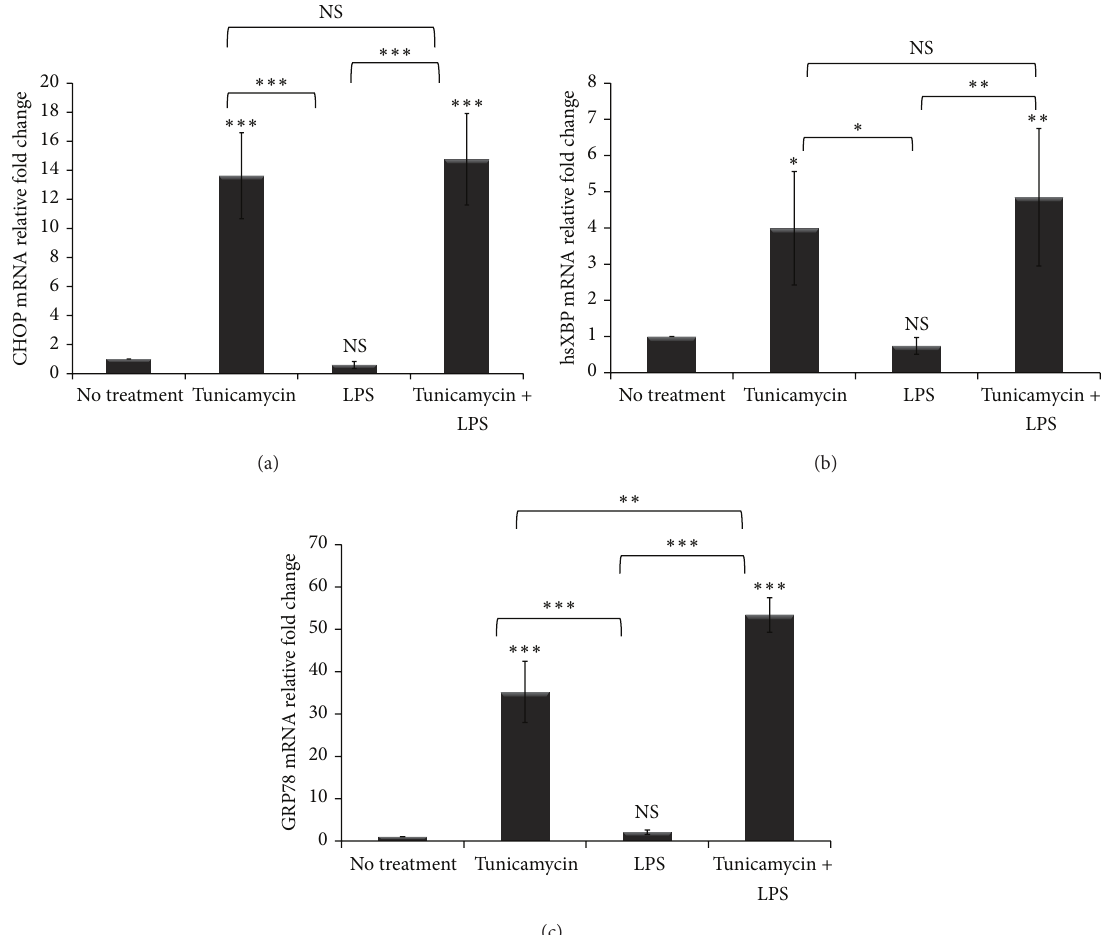
Figure 2: ER stress markers are induced in macrophages by tunicamycin. THP-1 cells ( 1 × 10 6 cells/mL) were treated with tunicamycin (10 𝜇 g/mL) or DMSO overnight prior to LPS exposure (40 ng/mL) for 6 hr. RNA was extracted and ER stress markers CHOP (a), hsXBP (b), and GRP78 (c) gene expressions were assessed by quantitative RT-PCR normalized to 𝛽 -actin. The fold change in CHOP and hsXBP gene expression was calculated in reference to DMSO treated control THP-1 cells using the ΔΔ CT method and presented here normalized to no treatment control. Error bars represent the SD from the mean of three independent experiments. ∗ 𝑃 values were calculated in reference to no treatment (DMSO only) control using one-way ANOVA followed by Bonferroni multiple comparisons post hoc analysis. 𝑃 values annotated ∗∗∗ 𝑃 < 0.0001 ; ∗∗ 𝑃 = 0.001 – 0.01 ; ∗ 𝑃 = 0.01 – 0.05 ; 𝑃 > 0.05 were not significant